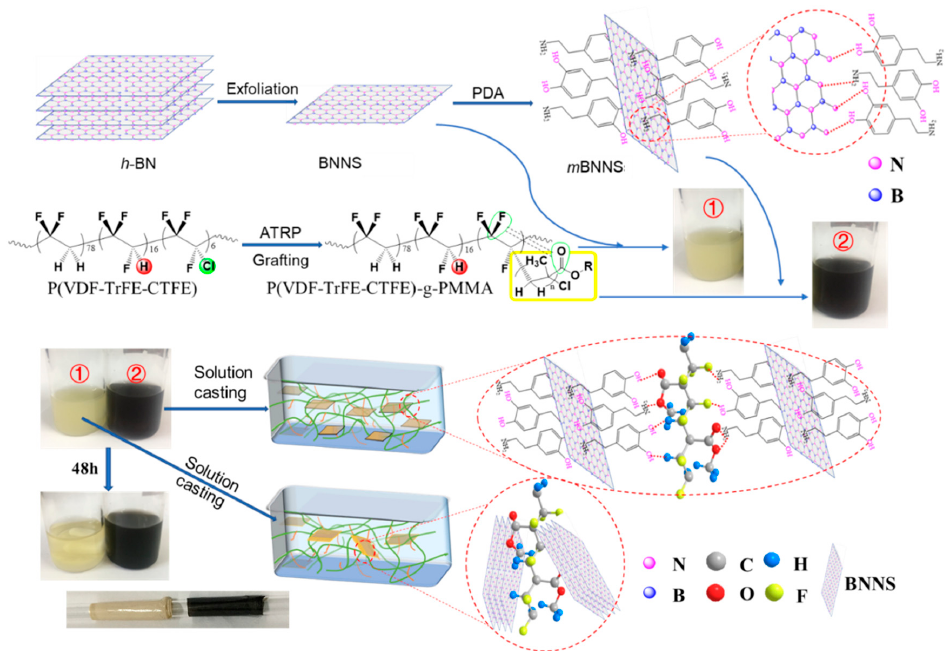
Figure 1. Schematic illustration for preparation of polymer nanocomposite film.